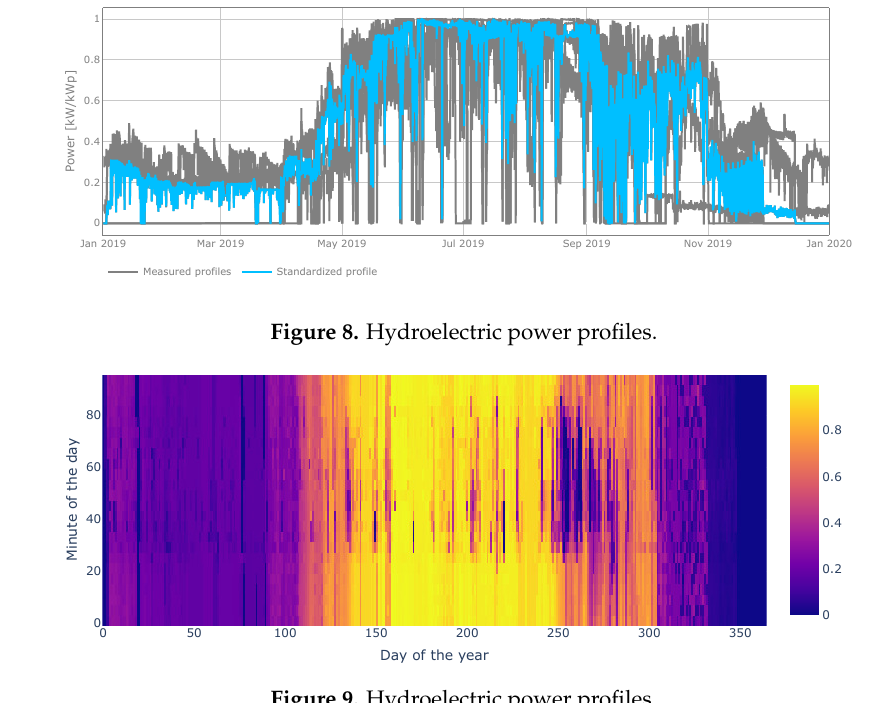
Figure 9. Hydroelectric power profiles. Table 2. Potential generator availability for the energy